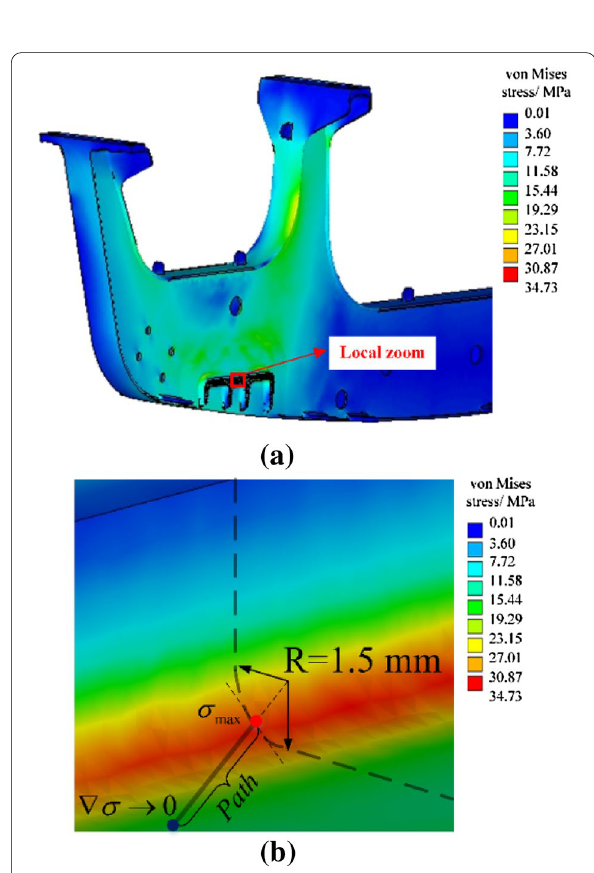
Figure 10 Stress concentration analysis of the beam, as obtained from numerical simulation with ANSYS: a Stress contour; b local zooming of the fillet